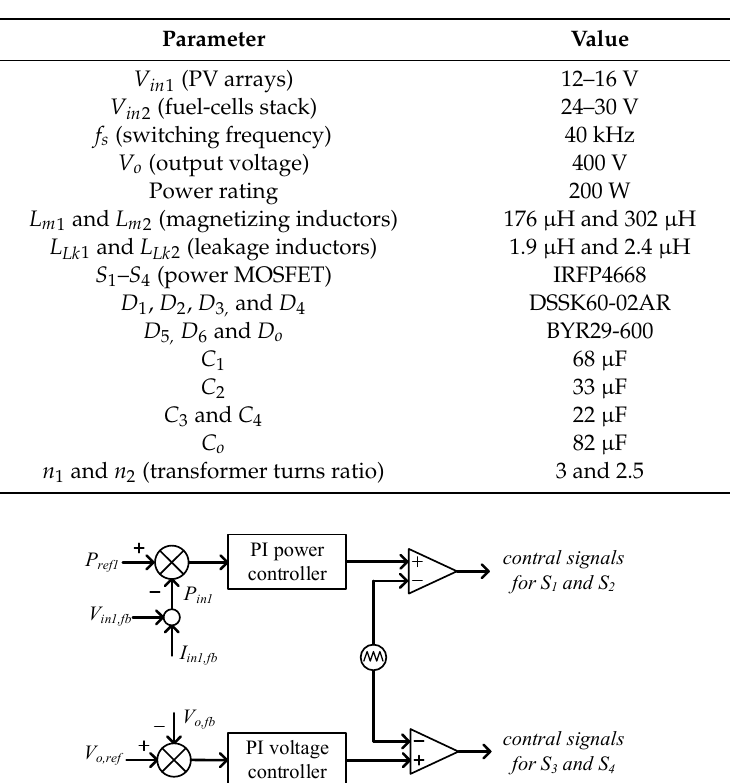
Table 2. Parameters of the DHSIC for Simulations and Practical Measurements.